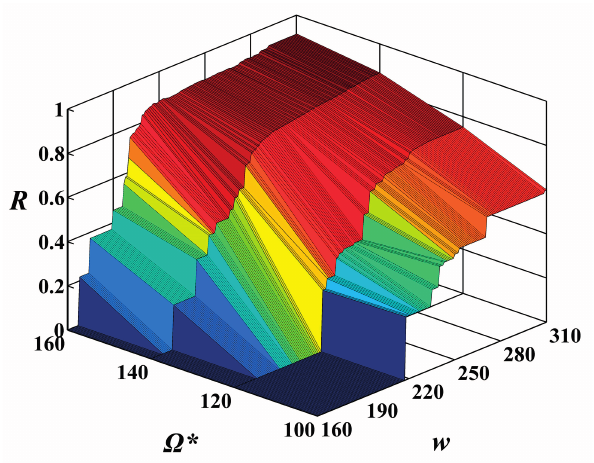
Figure 8. The values of reliability function R ( w * ) with alterations in the execution time w from 160 to 310 and in the given cost constraint Ω * from 100 to 160 under the given expected execution time w * = 250.